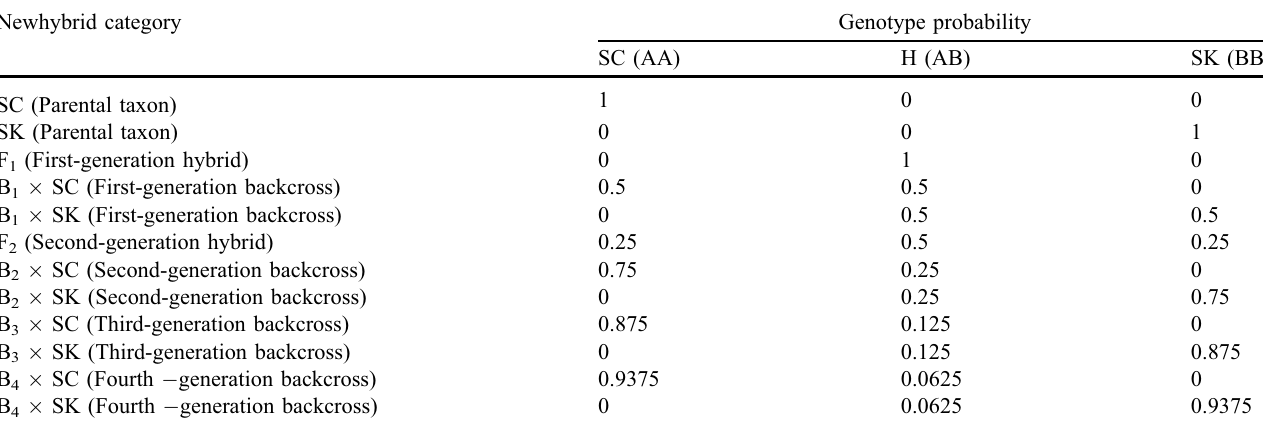
Table 2. Assignment criteria for S. chuatsi (SC), S. kneri (SK) and their hybrids (H). Newhybrid category